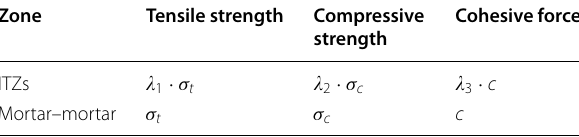
Table 4 Mesoscopic strength parameters of the